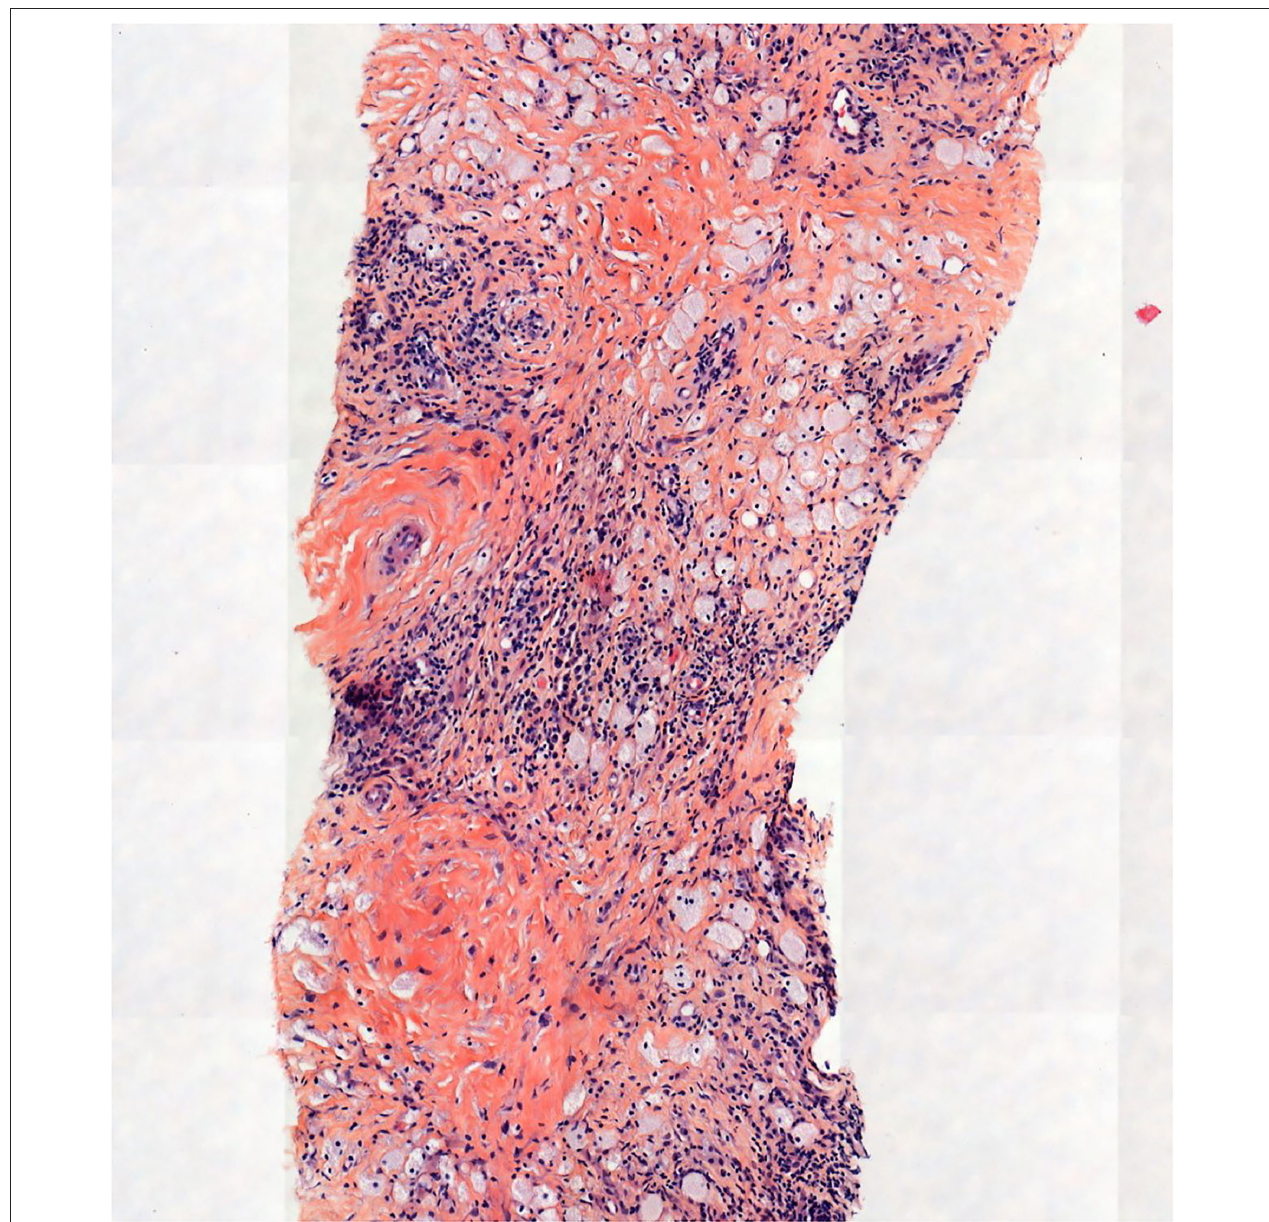
FIGURE 4 | Pathological examination showed perirenal fat and kidney capsule infiltrate made up of histiocytes, some of them with foamy cytoplasm (hematein-eosin-saffron, original magnification,